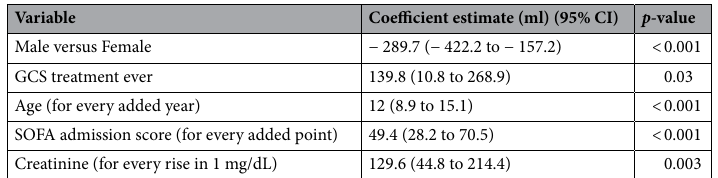
Table 3. Model 2 of the estimated effect of glucocorticoids (GCS) treatment per day on daily fluid balance (ml) in patients with sepsis in the intensive care unit (ICU). In this model, all the hospitalized days of patients who were treated with GCS were compared to all the hospitalized days of patients who were not treated with GCS. ICU intensive care unit, SOFA sequential organ failure assessment. *This table is linked to Fig. 4, which presents curves of the fluid balance for the days throughout admission.